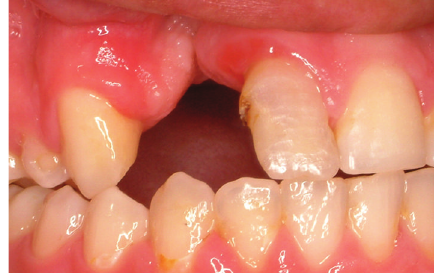
Figure 3: Metal-ceramic crowns with extracoronal attachments.